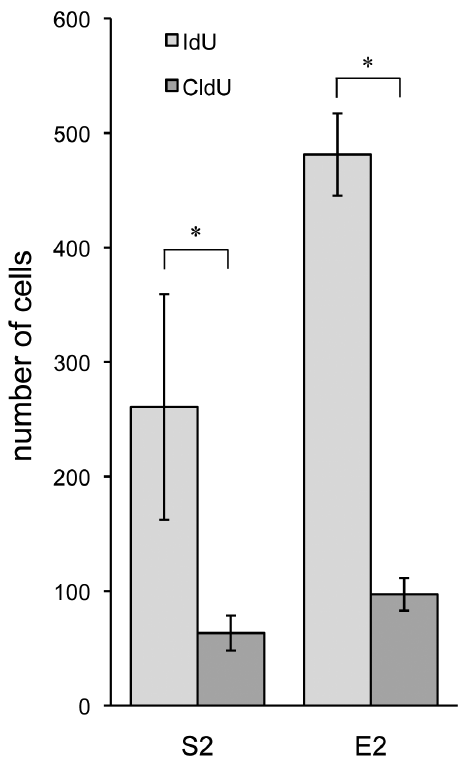
Figure 5. Fewer cells were labeled following a second binge. Cells generated 7 days after the first binge were labeled with IdU, while cells generated 7 days after the second binge were labeled with CldU. In both sedentary (S2) and exercised (E2) Two Binge animals, there were significantly fewer CldU + cells, compared with IdU + cells. *p , 0.05